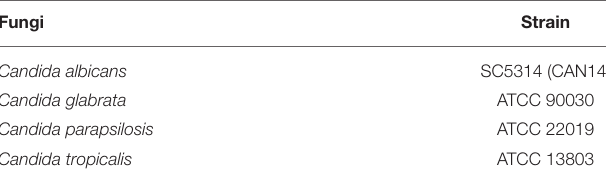
TABLE 1 | Microbial strains used in this study. Fungi